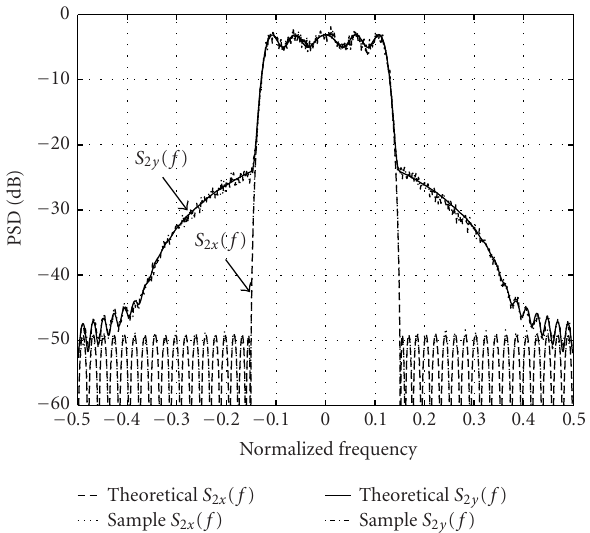
Figure 3: The theoretical S 2 x ( f ) is shown by the dashed line, the sample S 2 x ( f ) is shown by the dotted line; the theoretical S 2 y ( f ) is shown by the solid line, and the sample S 2 y ( f ) is shown by the dashed-dotted line.